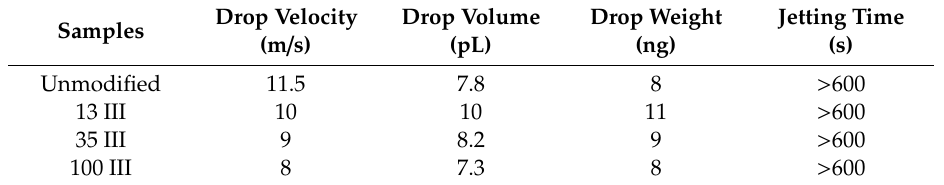
Table 3. Ink jetting properties for the ink samples Unmodified (a), 13 III (b), 35 III (c) and 100 III (d).